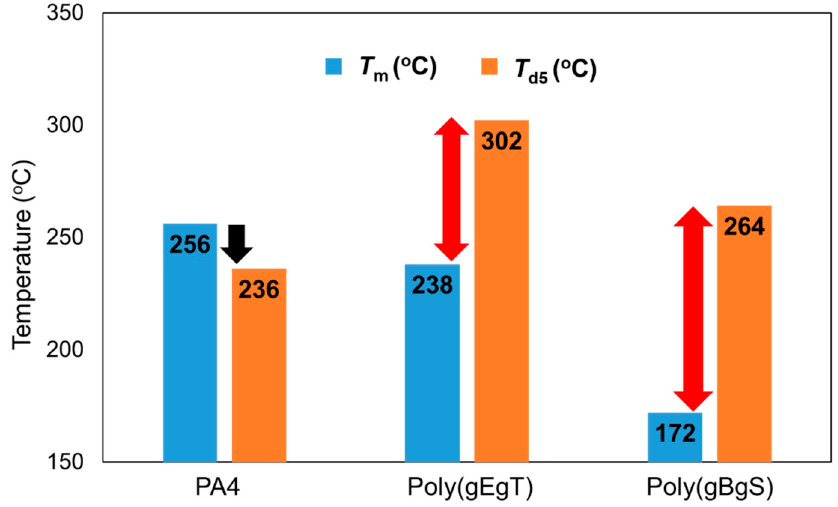
Figure 5. Comparison of melting and decomposition temperatures for the poly(ester amide)s. Black arrow: T m > T d5 . Red arrow: T m < T d5 .